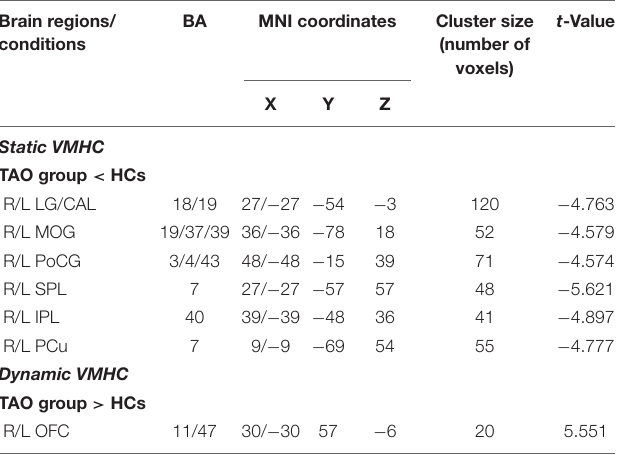
TABLE 2 | Brain areas with significantly different static and dynamic VMHC values between groups ( P < 0.05, cluster-level FWE corrected). Brain regions/